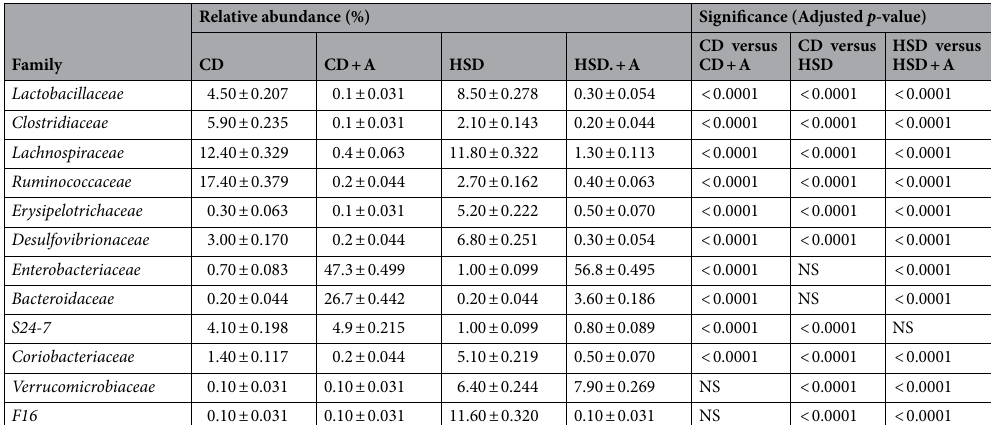
Table 6. Short term effect of high-salt (4% in chow) diet followed by amoxicillin treatment on the mean relative abundance of major bacterial groups at family level in mice. Values are expressed as the means ± SD. Data were analyzed by one-way ANOVA, followed by Bonferroni test, n = 6, p ≤ 0.05, NS = Not significant, CD: Standard—chow diet for 3 weeks; CD + A.: Standard—chow diet for 3 weeks and underwent Amoxicillin treatment in 3rd week; HSD: High-salt diet for 3 weeks; HSD + A.: High-salt diet for 3 weeks and underwent Amoxicillin treatment in 3rd week.